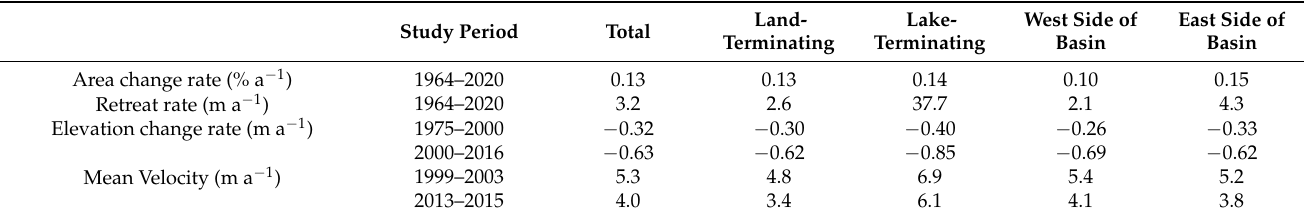
Table 2. Glacier changes between 1964 and 2020 for different glacier types and locations.